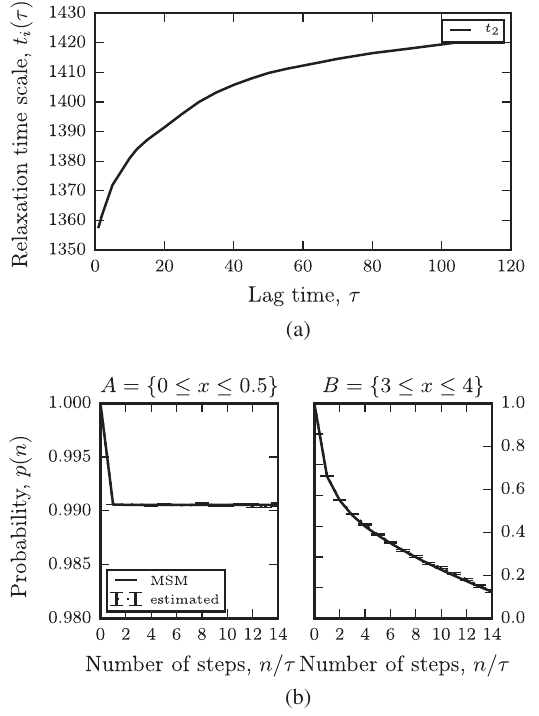
FIG. 14. (a) Implied time-scale test. Convergence of the largest relaxation time scale t 2 indicates a good Markov model fit; i.e., the slow eigenfunction of the associated dynamical operator is well approximated. (b) The Chapman-Kolmogorov test validates the Markov assumption by comparing the evolution of self-transition probabilities predicted by the MSM parametrized at lag time τ with direct estimates from the data at larger lag times n τ . Values are obtained from an ensemble of short trajectories starting in the high-energy region utilizing the equilibrium distribution in the estimation of the maximum likelihood estimator (MLE) transition matrix; cf. Eq.